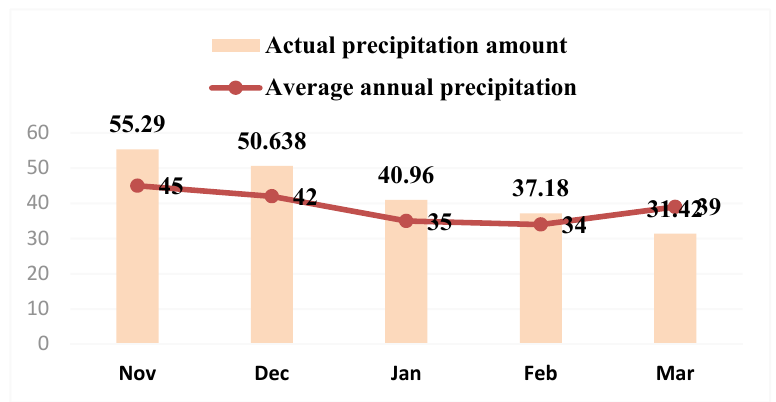
Figure 4. Average monthly precipitation rates in the epiphytotic years.